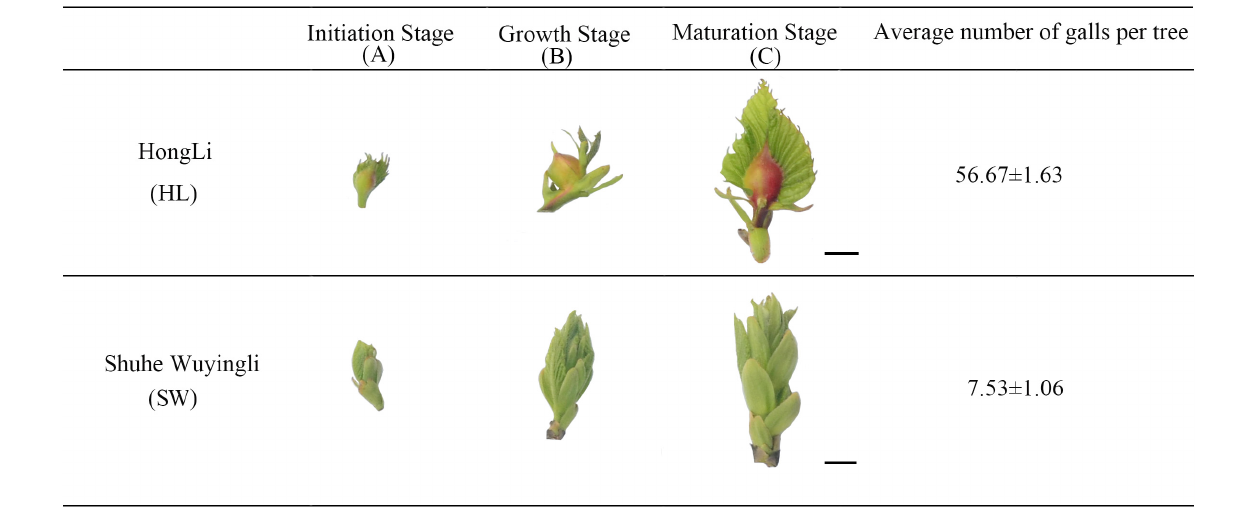
FIGURE 1 | Physicochemical changes during “HongLi (HL)” and “Shuhe_Wuyingli (SW)” bud development. The average number of galls per tree were analyzed. Mean ± standard error ( n = 12). Scale bar = 1